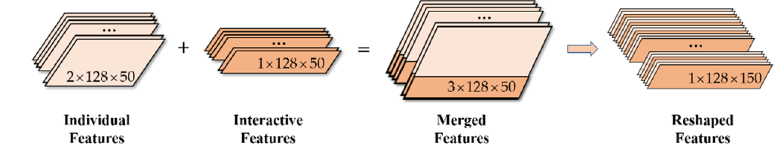
Figure 2. Feature merging by concatenation in length.